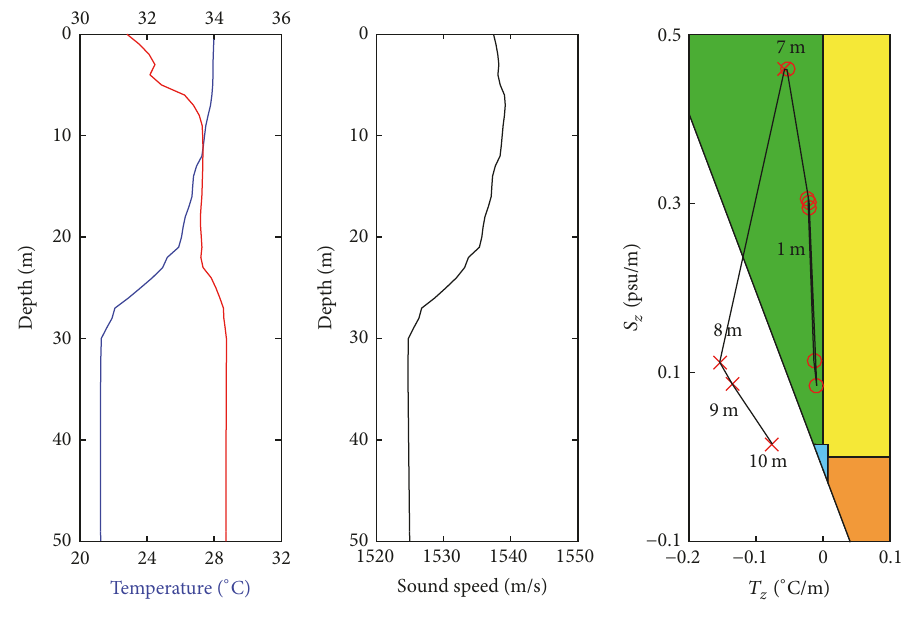
Figure 4: Typhoon genesis case.